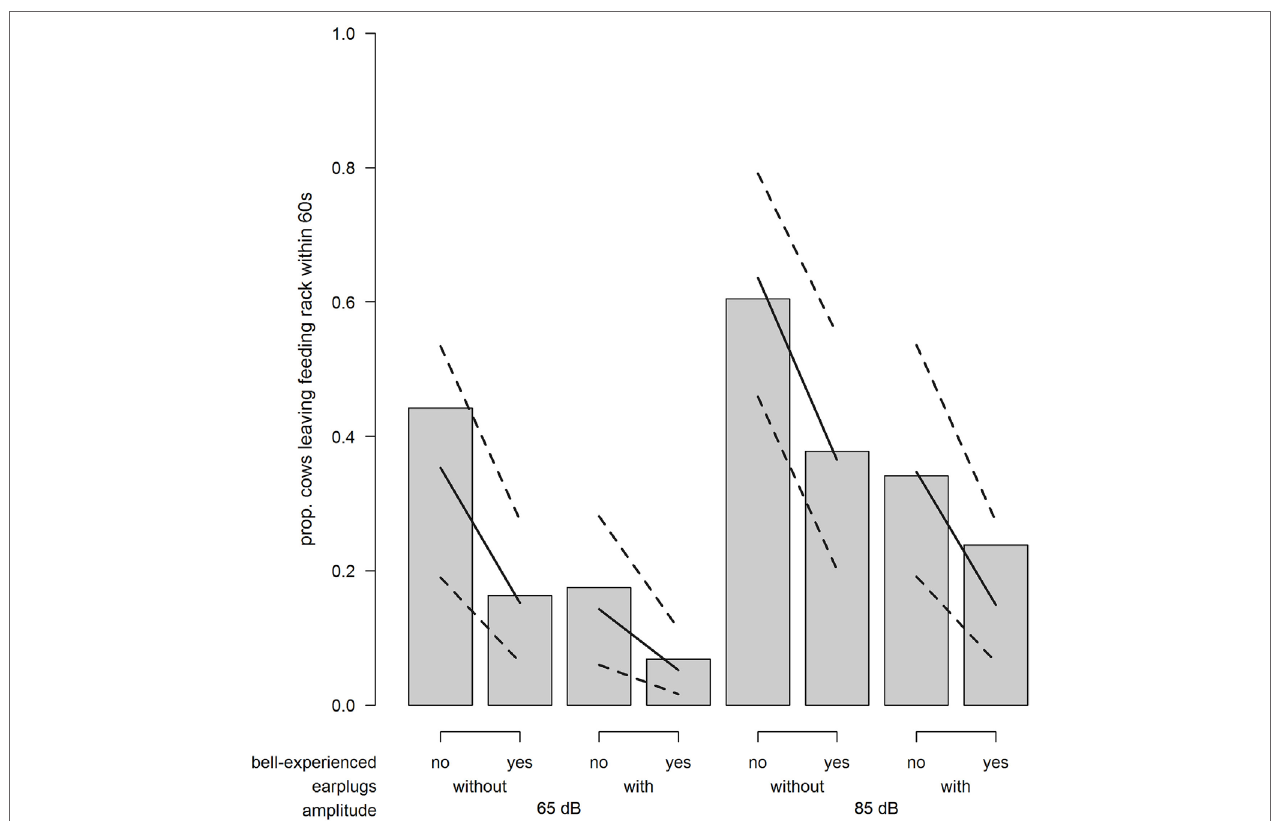
FigUre 5 | Avoidance. Proportion of cows leaving the feeding rack within 60 s after playback depending on bell-experienced (no, yes), earplugs (without, with), and amplitude (65, 85 dB). Solid lines show the model estimation, and dotted lines show the lower and upper 95% confidence